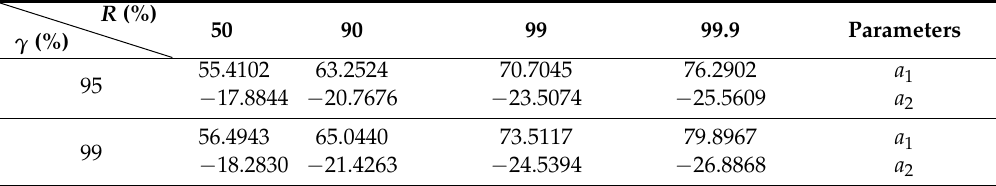
Table 7. Parameters of P–S–N curves at tempering temperature 500 ◦